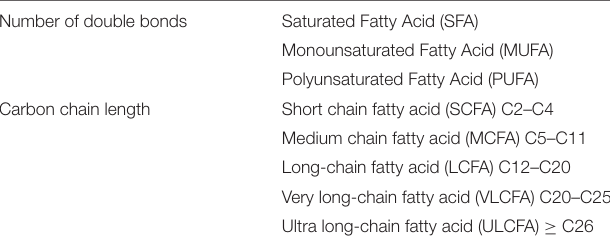
TABLE 3 | Classification of FAs according to carbon chain length and number of multiple bonds (5,